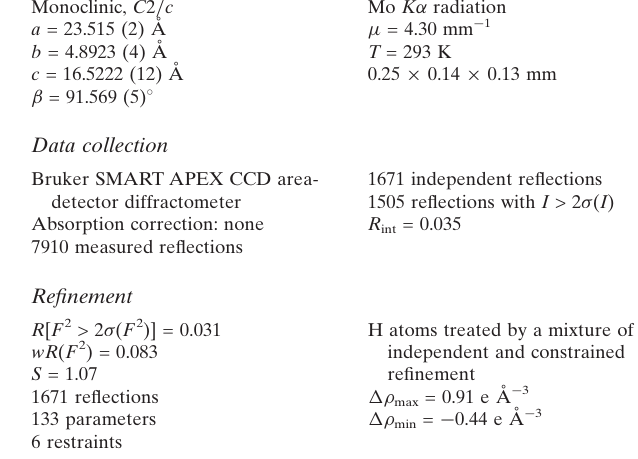
Data collection Bruker SMART APEX CCD area- detector diffractometer Absorption correction: none 7910 measured reflections